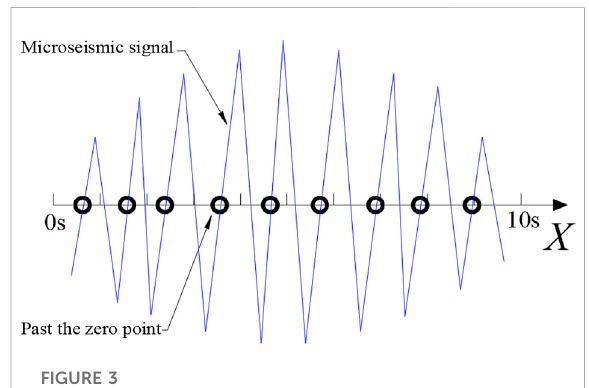
FIGURE 4 Overlap of P-wave and S-wave.